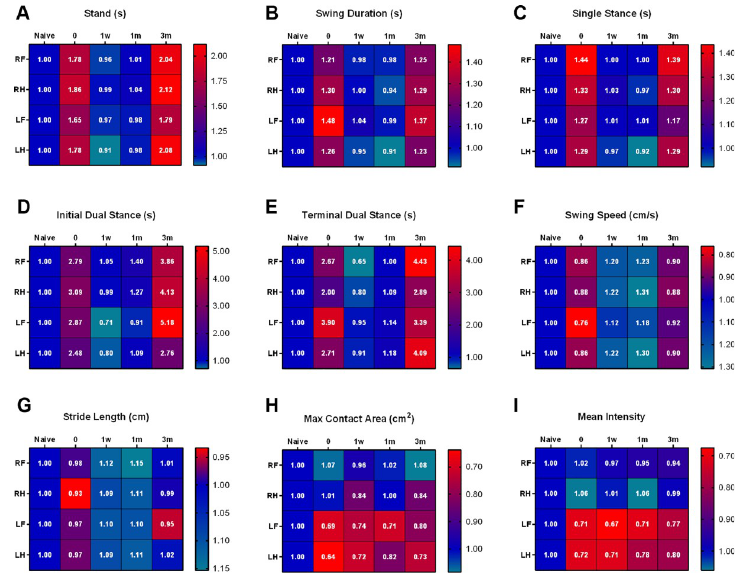
Fig 3. Summary of gait parameters. Summary of gait changes measured by the CatWalk apparatus in 6-OHDA infused rats treated with 0.5 ng of BoNT-A at experimental timepoints (n = 8). For each gait parameter, values represent the fold change compared to the na ï ve state of each paw. Blue reflects normalcy in the na ï ve state and red reflects dysfunction in the corresponding colour scale.